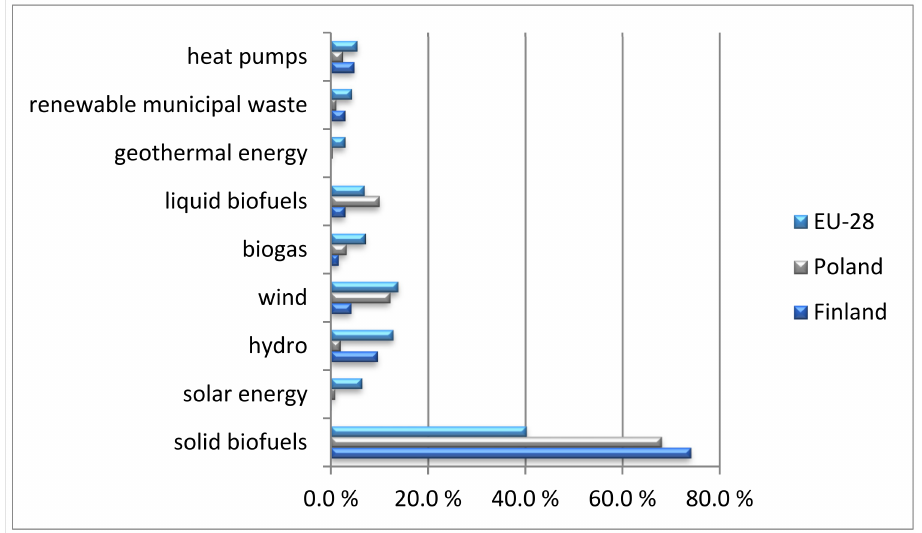
Figure 2. The structure of energy production from renewables in 2018. Own calculations based on